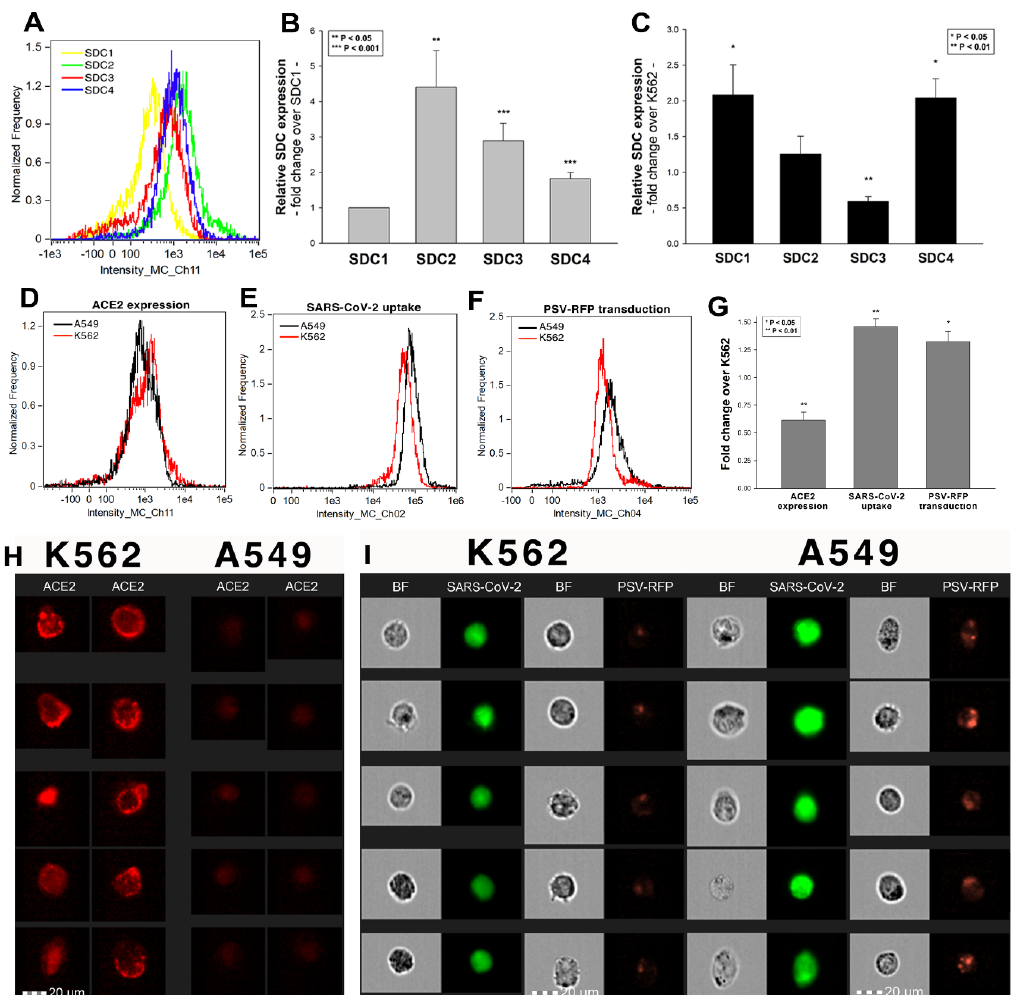
Figure 4. The difference of SARS-CoV-2 internalization in A549 and K562 cells. WT A549 and K562 cells were incubated with heat-inactivated SARS-CoV-2 (at 1 MOI) for 18 h at 37 ◦ C. After incubation, the cells were washed, trypsinized, fixed, permeabilized and treated with antibodies specific for the spike glycoprotein (along with AF 488-labeled secondary antibodies). Cellular uptake of SARS-CoV-2 was then analyzed with imaging flow cytometry. Other A549 and K562 cells were also incubated with 1 × 10 5 transducing units of SARS-CoV-2 PSV-RFP for 72 h. RFP expression was then measured with imaging flow cytometry. To investigate the effect of ACE2 and SDC expression on SARS-CoV-2 uptake, ACE2 and SDC expression of WT A549 and K562 cells (all untreated with SARS-CoV-2) were also analyzed with flow cytometry by using fluorescently labeled antibodies specific for ACE2 and SDC isoforms. ( A ) Representative flow cytometry histograms showing the expression levels of SDC isoforms in WT A549 cells. ( B ) Detected SDC expression levels in A549 cells were normalized to that of SDC1. The bars represent the mean ± SEM of nine independent experiments. Statistical significance vs. SDC1 expression was assessed with ANOVA. ** p < 0.01; *** p < 0.001. ( C ) SDC expression of WT A549 and K562 cells was measured with flow cytometry. Detected SDC expression levels in A549 cells were normalized to that of K562 cells as standards. The bars represent the mean ± SEM of three independent experiments. Statistical significance vs. standards was assessed with ANOVA. * p < 0.05; ** p < 0.01. ( D ) Representative flow cytometry histograms showing the ACE2 expression levels in WT K562 and A549 cells. ( E ) Representative flow cytometry histograms showing the intracellular fluorescence of SARS-CoV-2-treated WT K562 and A549 cells. ( F ) Representative flow cytometry histograms showing the RFP fluorescence of SARS-CoV-2 PSV-treated WT K562 and A549 cells. ( G ) ACE2 and RFP expression and SARS-CoV-2 internalization levels were normalized to those of WT K562 cells as standards. The bars represent the mean ± SEM of three independent experiments. Statistical significance vs. standards (WT K562 cells) was assessed with ANOVA. * p < 0.05; ** p < 0.01. ( H ) Fluorescent images representing the ACE2 expression of K562 and A549 cells. Scale bar = 20 µ m. ( I ) BF and fluorescent images of SARS-CoV-2- and SARS-CoV-2 PSV-treated K562 and A549 cells. Scale bar = 20 µ